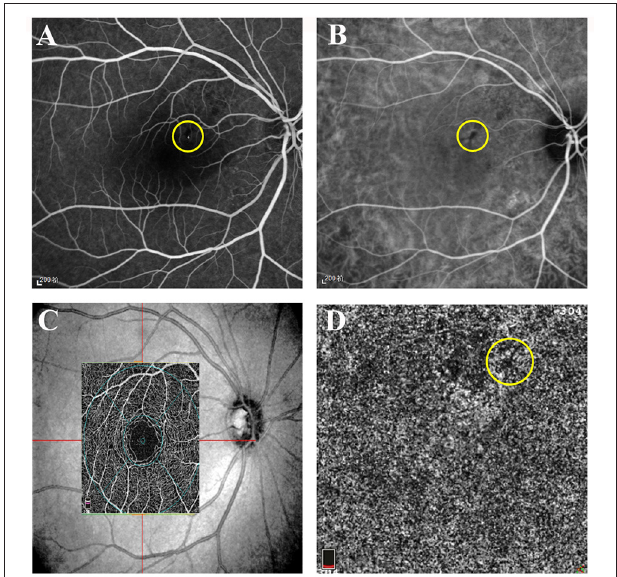
FIGURE 1 | Representative images of active central serous chorioretinopathy (CSC). (A) Early-phase fundus fluorescein angiography (FFA) of the right eye of a 39-year-old female patient with acute CSC. A hyperfluorescent superofoveal was visible and marked by a yellow circle . (B) Early-phase indocyanine green angiography (ICGA) of the same patient showing a hypofluorescent area and marked by a yellow circle . (C) The superficial retina layer and the corresponding location of the 3 × 3 image on optical coherence tomographic angiography (OCTA). (D) The low signal area at the leakage point corresponding to FFA and